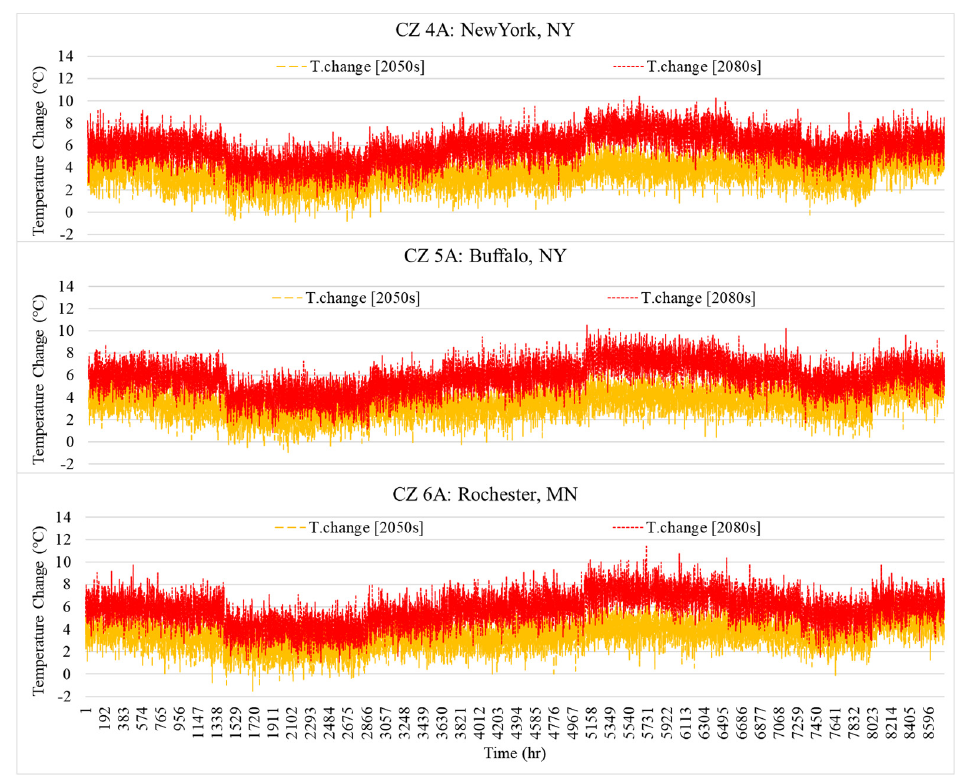
Figure 4. Hourly changes in generated temperature based on the two different scenarios.